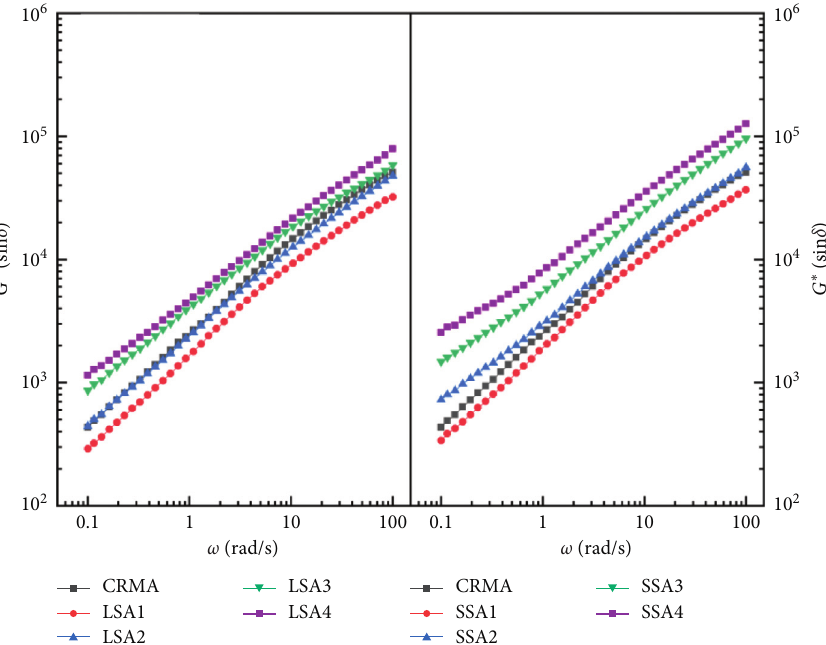
Figure 9: Variation of G ∗ /sin δ with the SBS contents for modified asphalts.